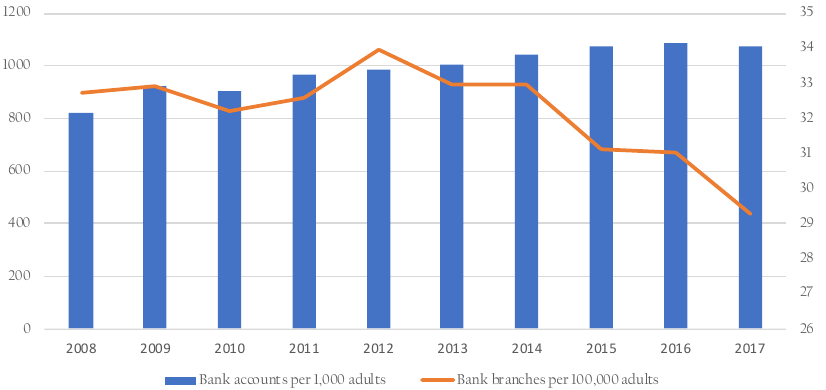
Figure 4. Number of bank accounts and bank branches per 1,000,000 in Poland over the period 2011–2017 (World Bank: Financial Development